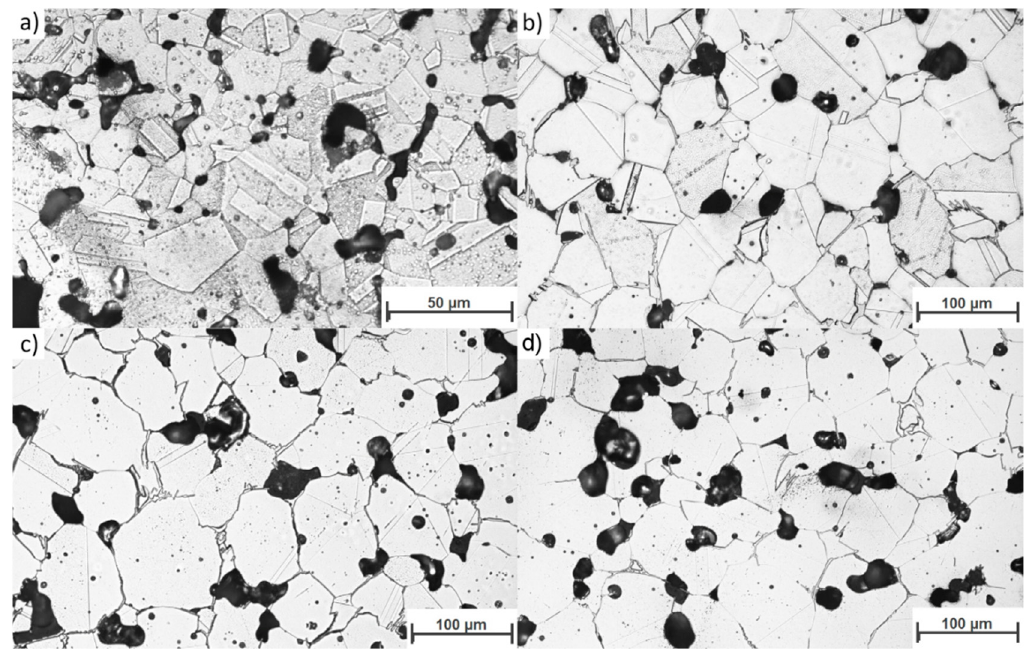
Figure 6. Representative microstructures of selected samples; ( a ) 0-0; ( b ) 4-0; ( c ) 4-4; and ( d ) 4-8. Table 4. Comparison of average grain sizes for selected samples.